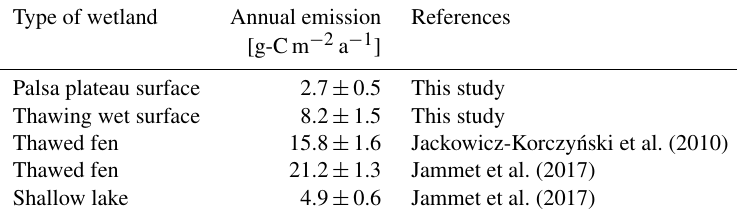
Table 9. Annual CH 4 emission from different components of the Stordalen Mire complex from EC